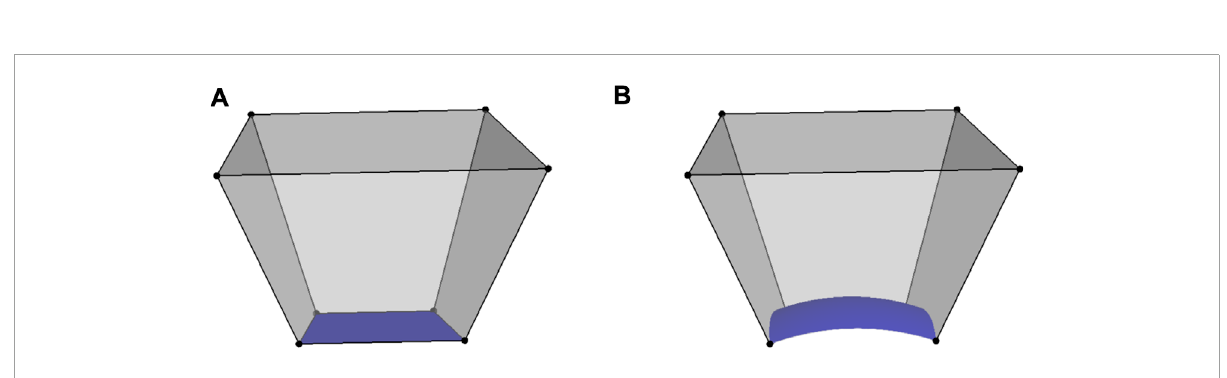
FIGURE 2 Hexahedral cells: (A) the interior cell, (B) the boundary